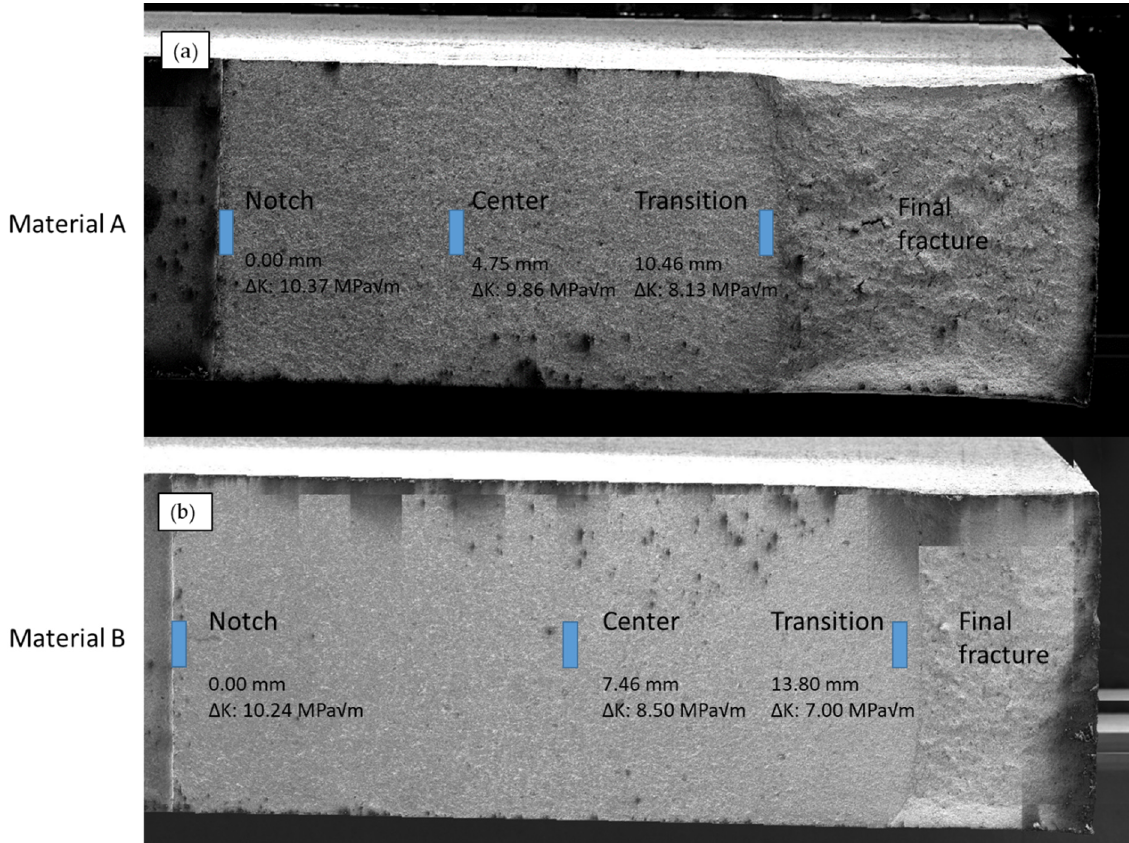
Figure 6. Overview images of the fatigue crack surfaces (20 mm × 6 mm) from the notch to the transition into final fracture: ( a ) Material A: coarse microstructure; ( b ) Material B: fine microstructure.